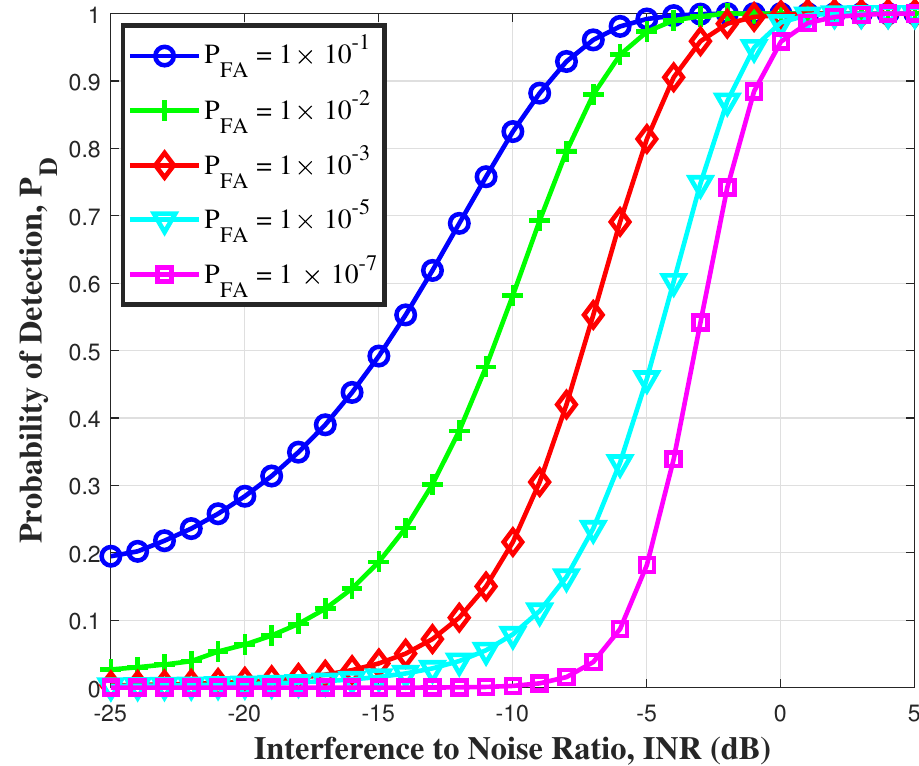
Figure 3. Detection performance of UWB system on linear P FA scale.